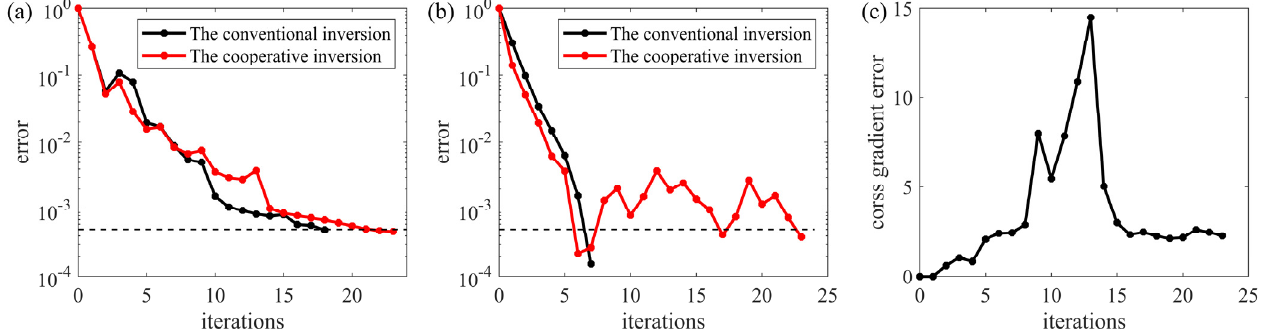
Figure 12. Comparison of the data errors between the conventional inversion and cooperative inversion: ( a ) iterative error of the ATEM inversion; ( b ) iterative error of the magnetic inversion; ( c ) cross-gradient value. Table 3. Lithologic parameters of model